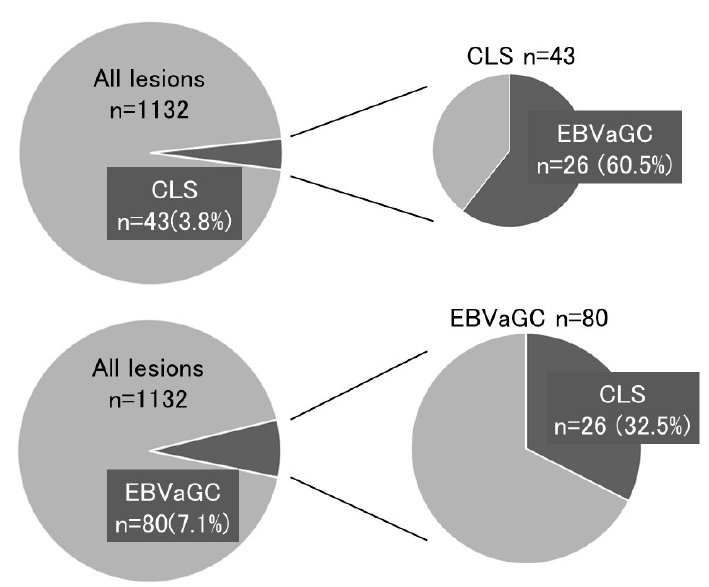
Figure 3. Relationship between Epstein–Barr virus-associated gastric carcinoma (EBVaGC) and carcinoma with lymphoid stroma